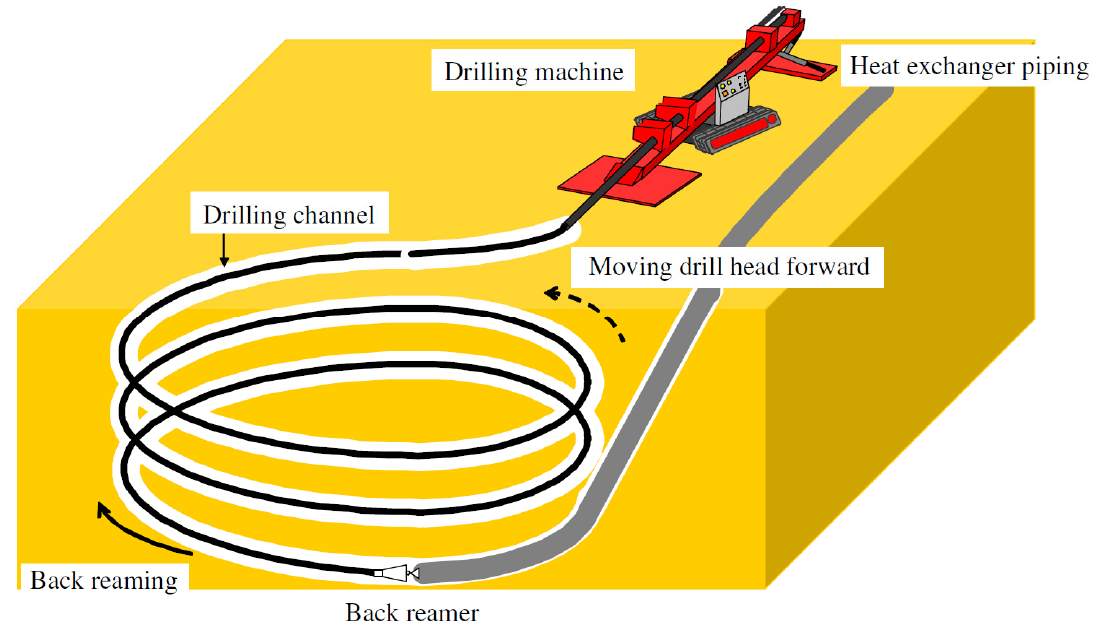
Figure 4. Installation process using no-dig method [64].